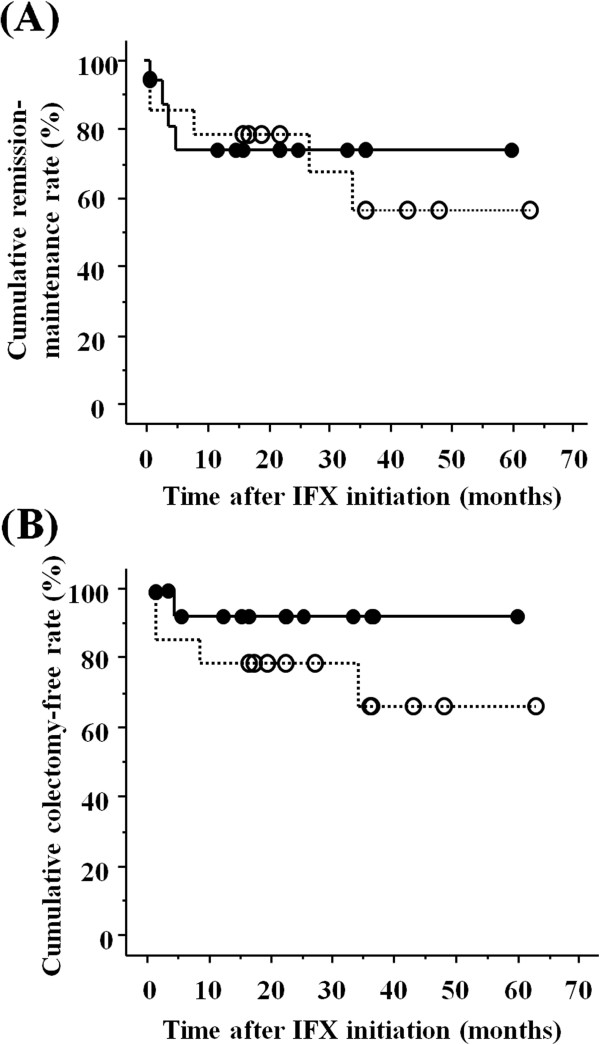
Survival curves between in patients receiving IFX and immunomodulators and IFX alone. (A) Cumulative remission-maintenance rates in patients receiving combination therapy (solid line) and IFX monotherapy (dotted line). Rates were similar in these two groups (73.9% at 60 months vs 56.1% at 63 months, p = 0.74). (B) Cumulative colectomy-free rates in patients receiving combination therapy (solid line) and IFX monotherapy (dotted line). These rates were also similar (91.7% at 60 months vs 66.2% at 63 months, p = 0.21).